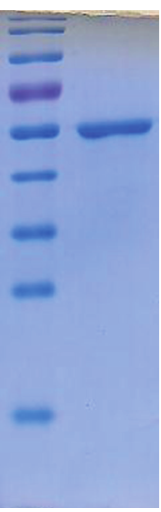
Figure 1: Molecular structure of myricetin (Myr), quercetin (Que), kaempferol (Kae), and galangin (Gal). Figure 2: Coomassie Blue-stained SDS-PAGE (12%) of the purified Kp DnaB and molecular mass standards. The sizes of the standard proteins, from the top down, are as follows: 170, 130, 100, 70, 55, 40, 35, 25, and 15